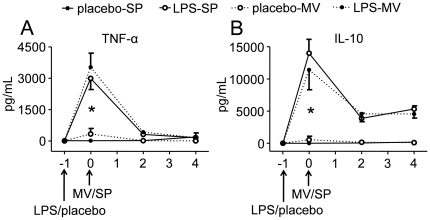
Effects of ventilation with 8 mL/kg in LPS- or placebo-pretreated rats on systemic inflammation.Plasma concentrations of pro-(A: TNF-α) and anti-inflammatory (B: IL-10) cytokines in placebo- and LPS-treated spontaneously breathing (SP) and mechanically ventilated (MV, 8 mL/kg) rats. Data are represented as mean ± SEM of 8–9 animals per group. * indicates p<0.05 between placebo- and LPS-treated groups (one-way ANOVA with Bonferroni post-hoc test). There were no differences between the placebo-SP and placebo-MV or the LPS-SP and LPS-MV groups.